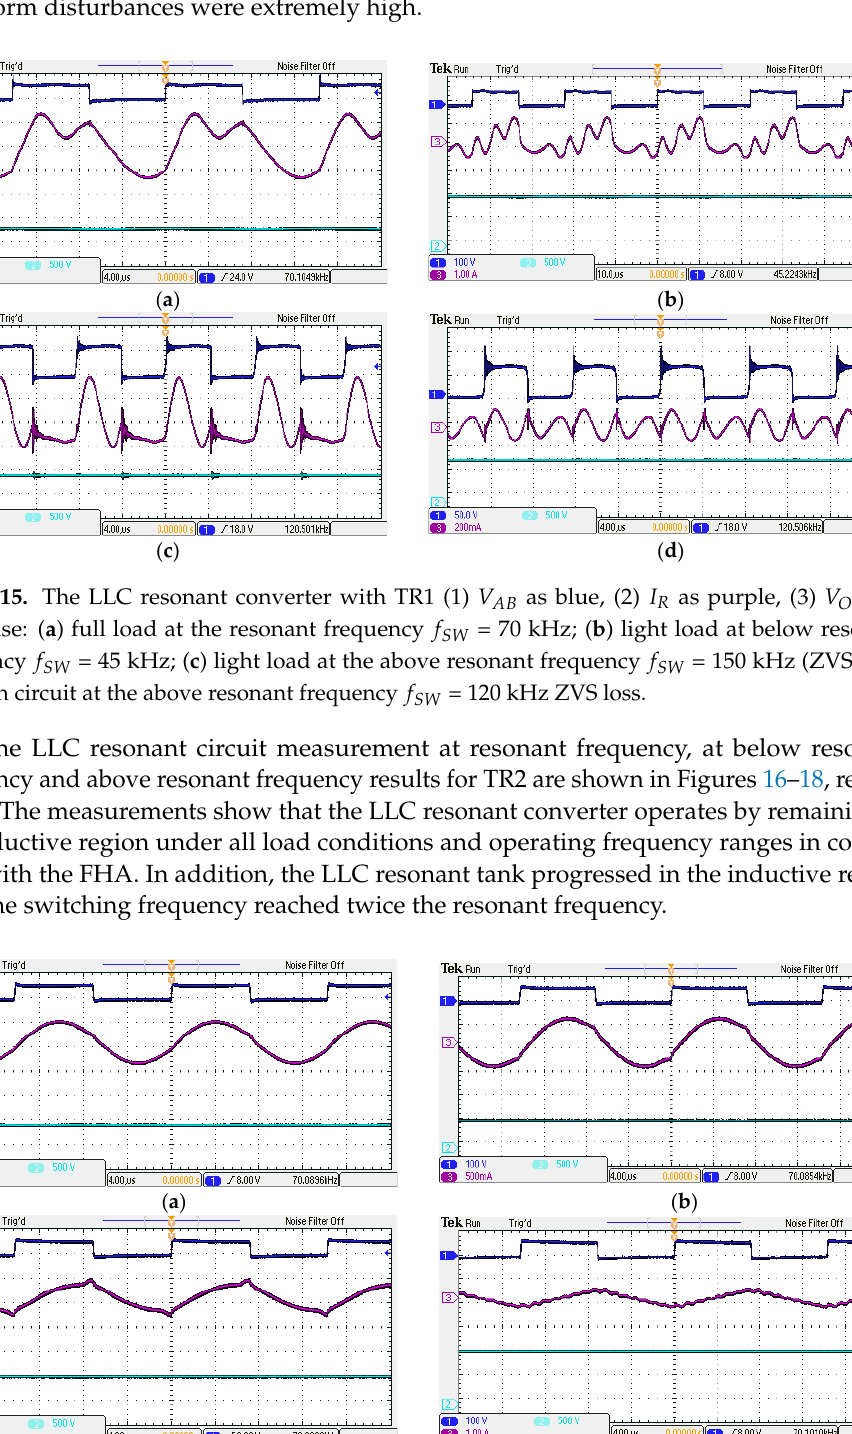
Figure 16. LLC resonant converter improvement for primary-side switches at the resonant frequency f SW = 70 kHz (1) V AB as blue, (2) I R as purple, (3) V OUT as turquoise: ( a ) full load; ( b ) heavy load; ( c ) light load; ( d ) open circuit.